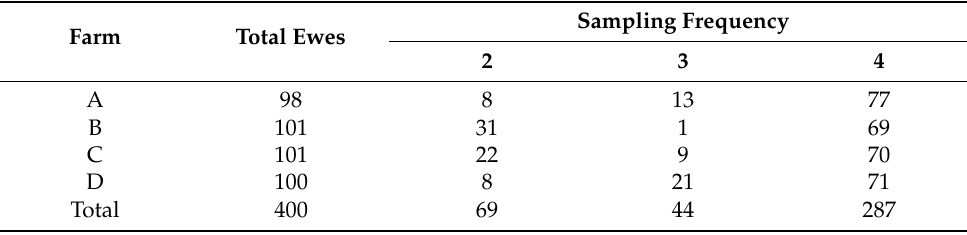
Table 2. Distribution of ewes ( n = 400) by farm and sampling